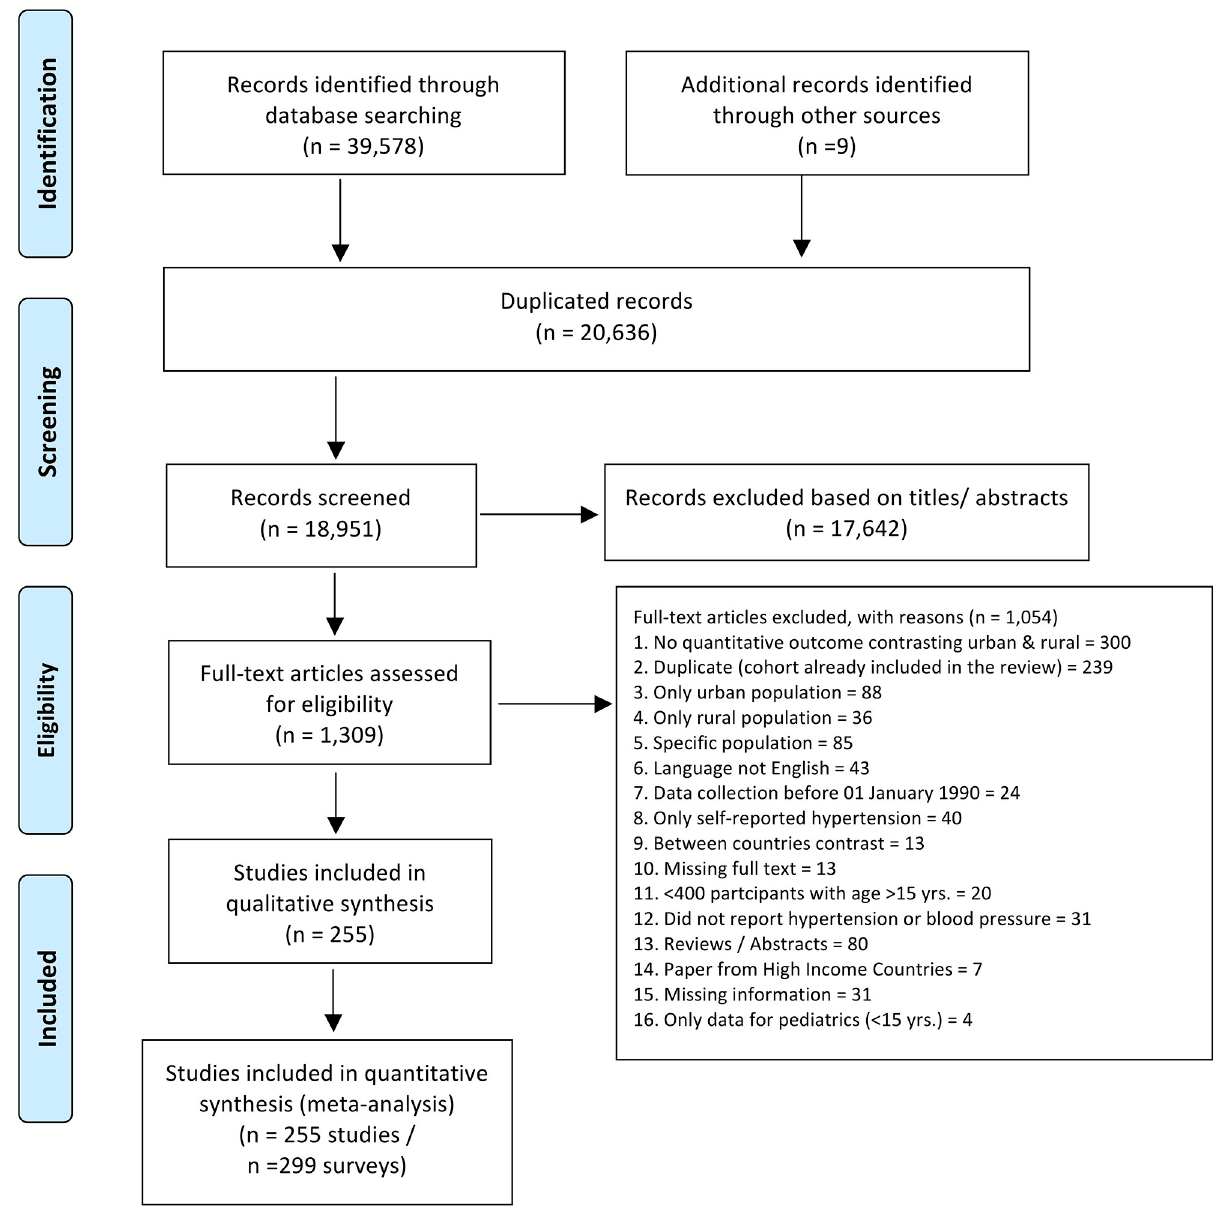
Fig 1. PRISMA flowchart. Study flowchart after systematic search between 01/01/1990 and 10/03/2022 in the PubMed, Web of Science, Scopus, and Embase databases. (95% CI, 25.0 to 30.4) in LIC to 35.1% (95% CI, 32.3 to 37.9) in UMIC (S3 Data). The overall rural prevalence of hypertension across country region ranged from 23.8% (95% CI, 20.3 to 27.3) in South Asia to 43.8% (95% CI, 37.8% to 49.8%) in Europe and Central Asia. The overall urban prevalence of hypertension across country region ranged from 27.6% (95% CI, 22.3 to 32.9) in Middle East and Central Asia to 37.7% (95% CI, 31.7% to 43.7%) in Europe and Cen- tral Asia (S3 Data).